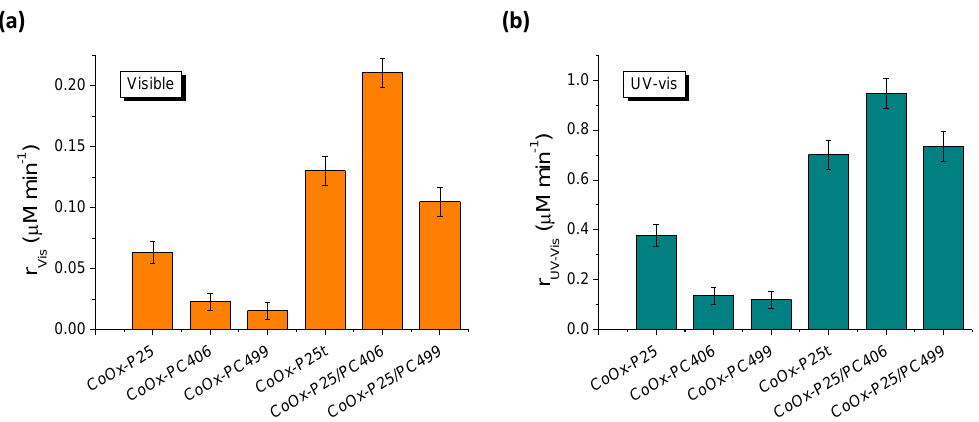
Figure 7. SA reaction rates of for the monolithic and bilayer CoO x -TiO 2 films under ( a ) visible and ( b ) UV-Vis irradiation.